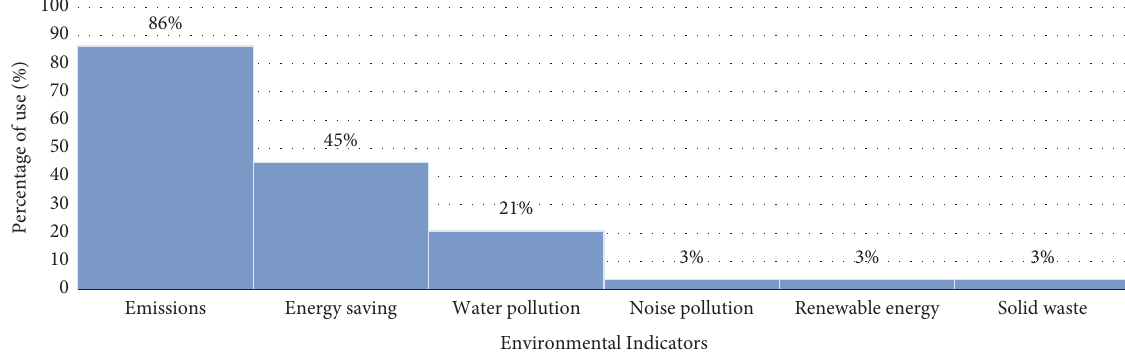
Figure 5: ML-based articles in terms of environmental sustainability in maritime port logistics.